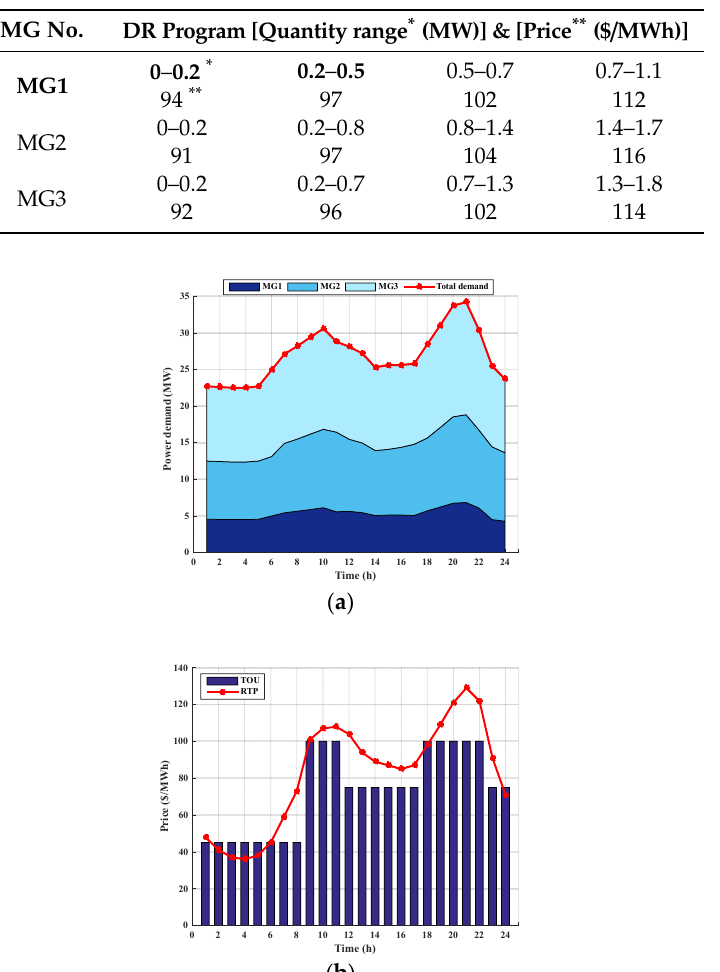
Figure 5. ( a ) Power demand; ( b ) Real Time Pricing (RTP) Wholesale market and Time-of-Use (TOU) retail market prices.